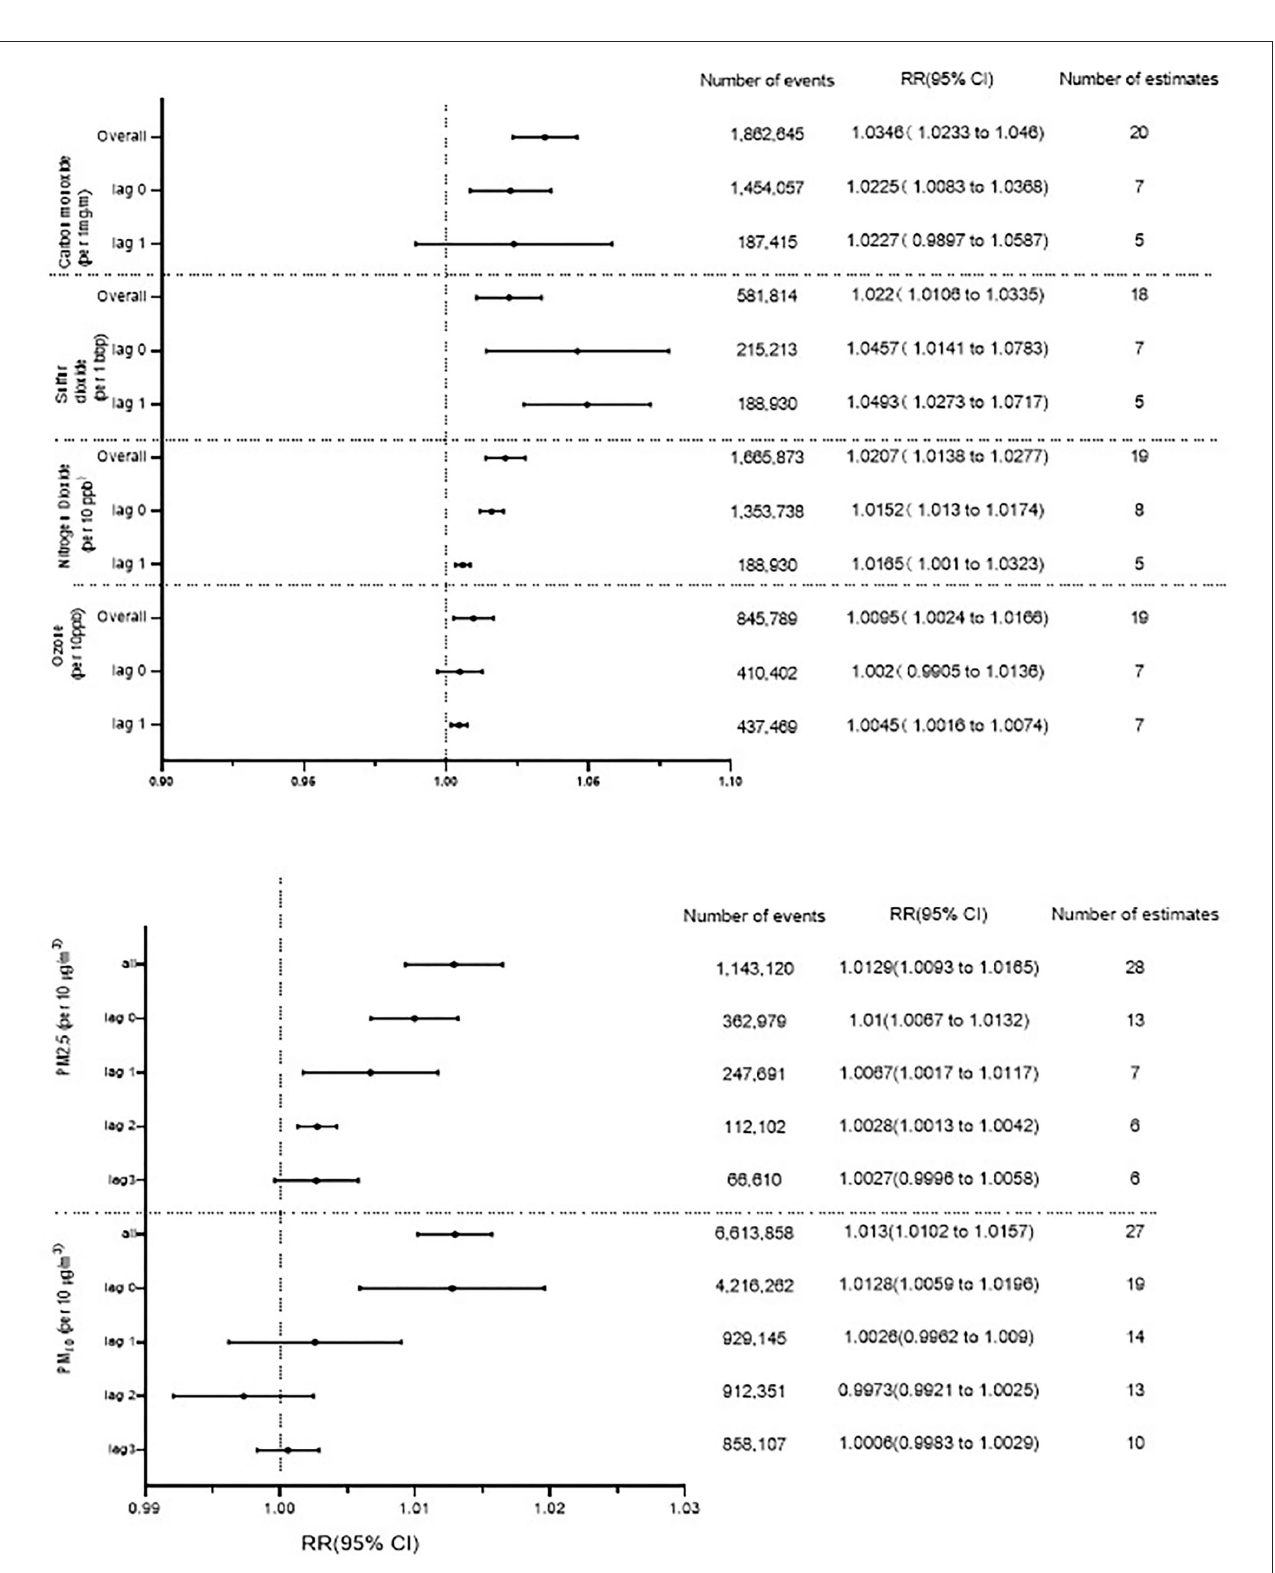
FIGURE2 Association between gaseous and particulate air pollutants and heart failure hospitalization or heart failure mortality. ppm, parts per million; ppb, parts per